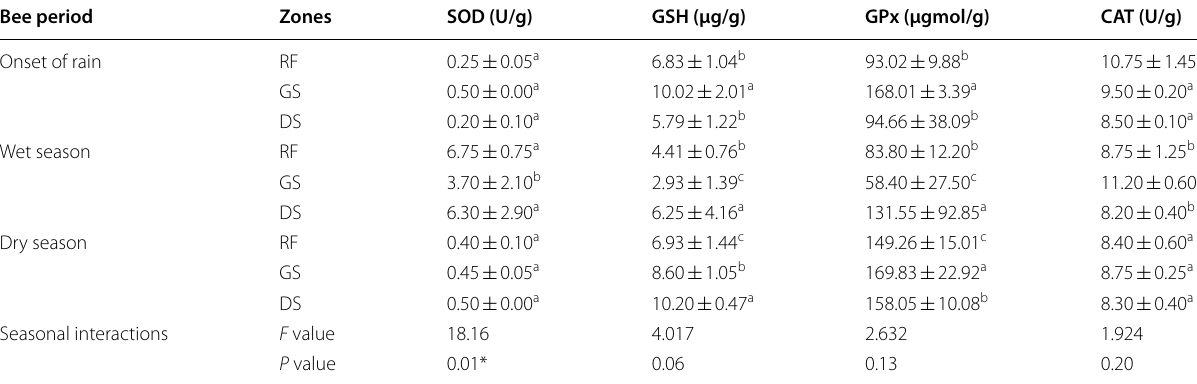
Table 3 Levels of antioxidant enzymes in the honeybees from the three ecological zones of Nigeria during the dry season, onset of rain and wet seasons